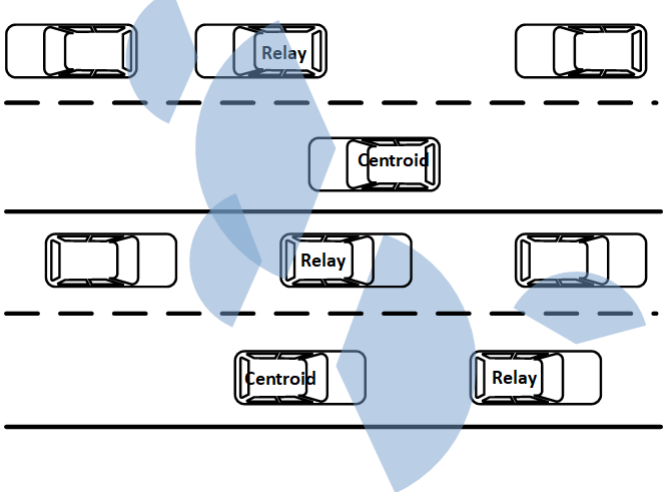
Figure 2. Information broadcasting relaying in a four-lane and two-direction